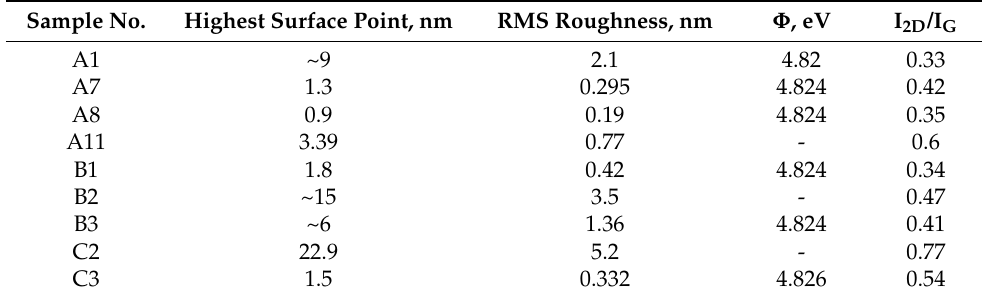
Table 2. AFM parameters of the directly synthesized graphene samples. Sample No.